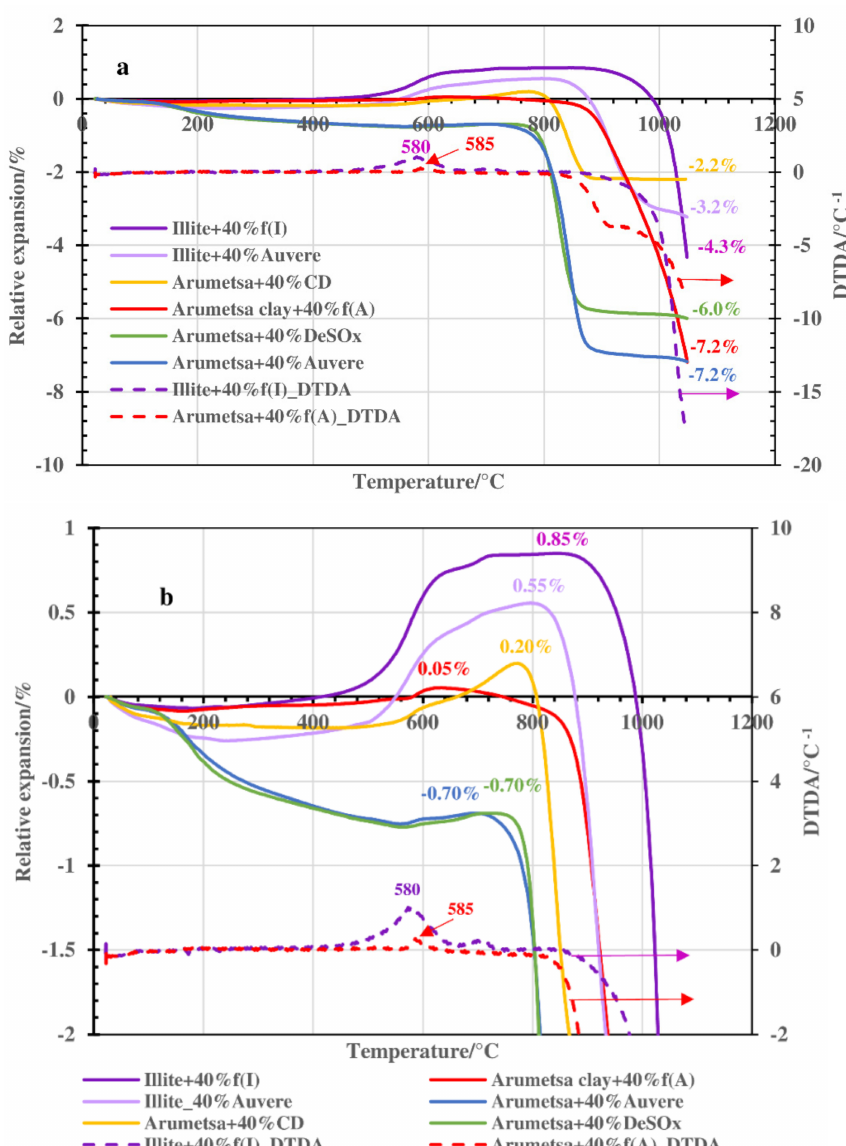
Figure 4. Thermodilatometric curves of Arumetsa and illitic clay with different additives heated up to 1050 ◦ C: ( a ) up to 1050 ◦ C and ( b ) up to 1000 ◦ C